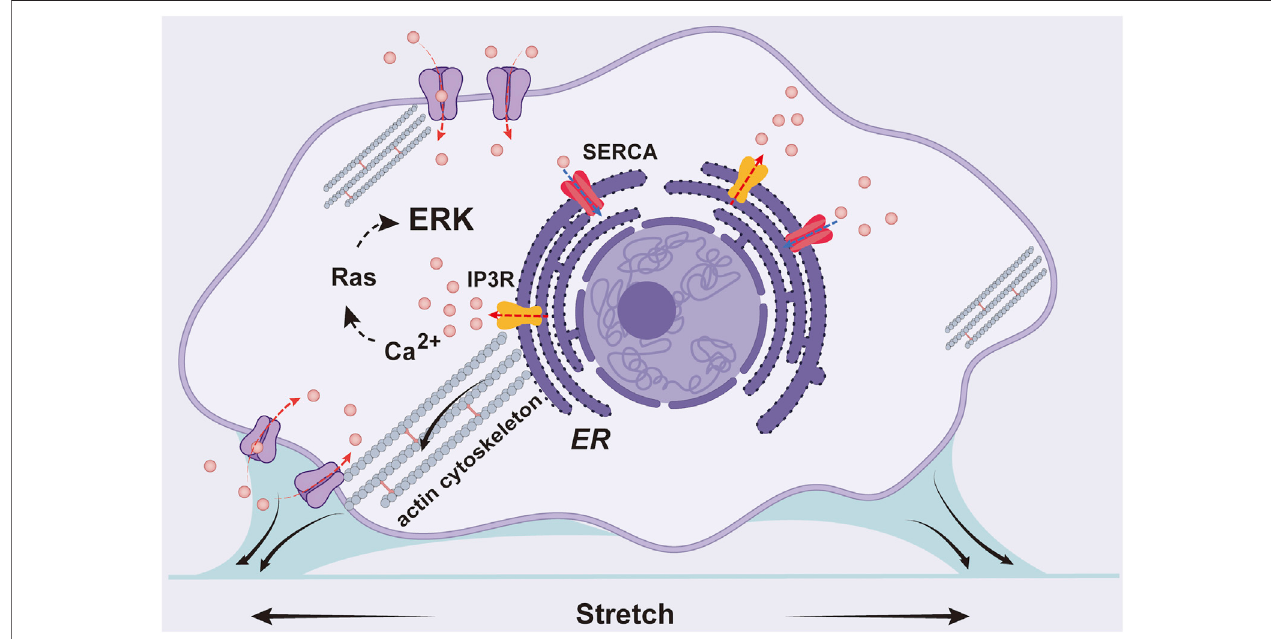
FIGURE7| Aschematicillustration forthemechanicalactivationofERKinASMcells.Thecyclicstretchapplied onthecellsactivatesCa 2+ channelsontheplasma and ER membranes including IP 3 R and SERCA pump, likely mediated by force transmission through actin cytoskeleton, and Ca 2+ signals further trigger downstream pathway to activate